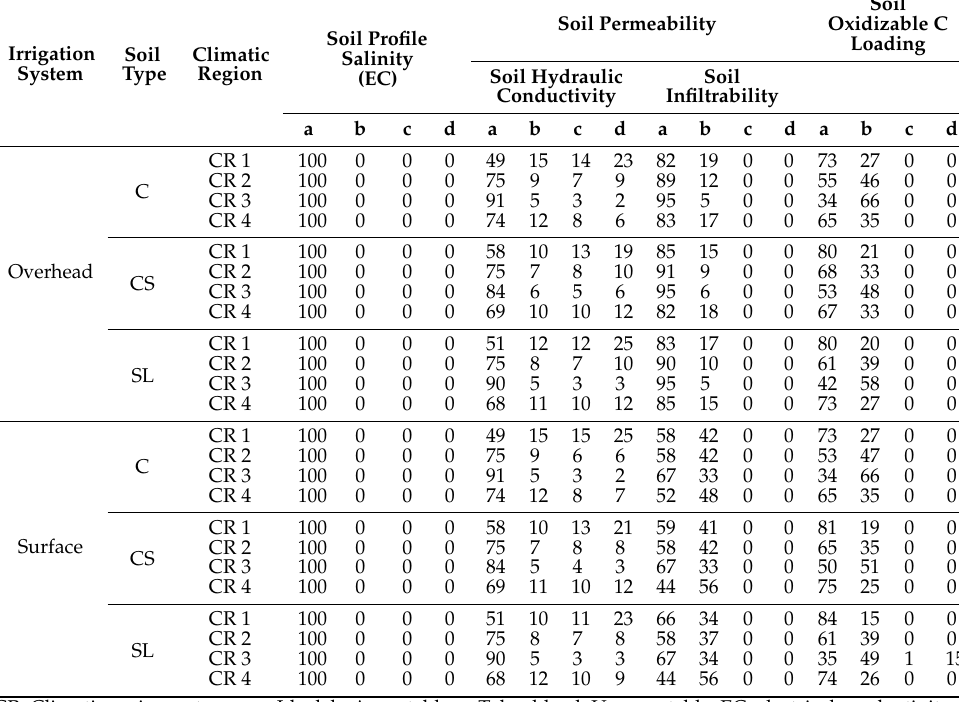
Table 5. The fitness for use of AF effluent with respect to soil quality of various soil types (clay; C, coarse sand; CS and sandy loam; SL), irrigation systems (overhead and surface) in four climatic regions (climatic region 1; CR1, 2; CR2, 3; CR3 and 4; CR4).